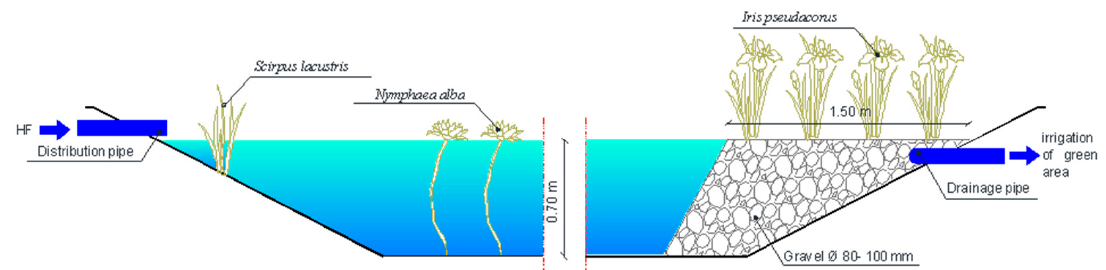
Figure 4. Section of the free surface flow unit (FSF) CW bed located at the Marabino winery.